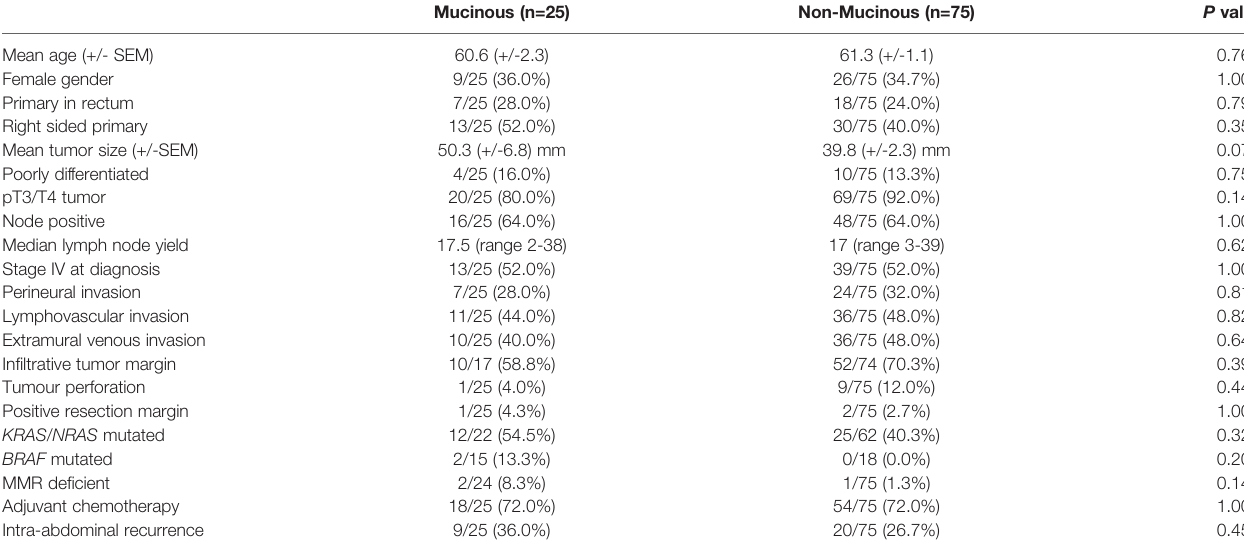
TABLE 1 | Primary tumour